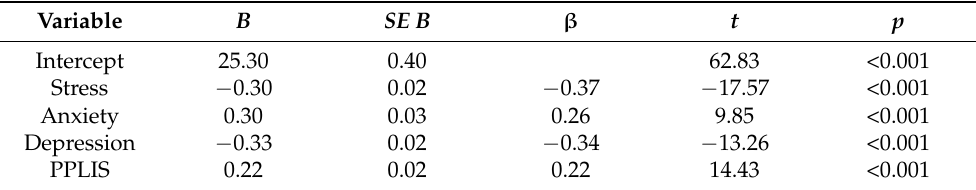
Table 2. Multiple linear regression for life satisfaction ( N = 3230).